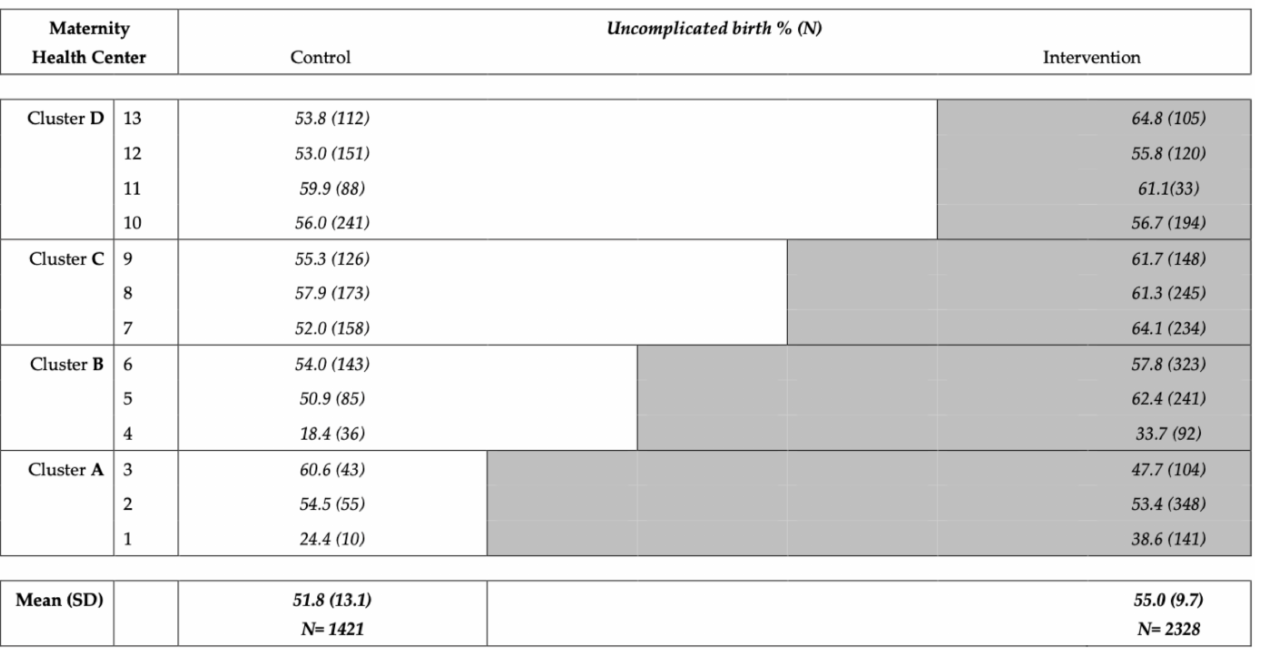
Figure 3. Percentage and numbers of uncomplicated births per maternity health center and overall (total 95% confidence interval) before and after the introduction of My Pregn@ncy.